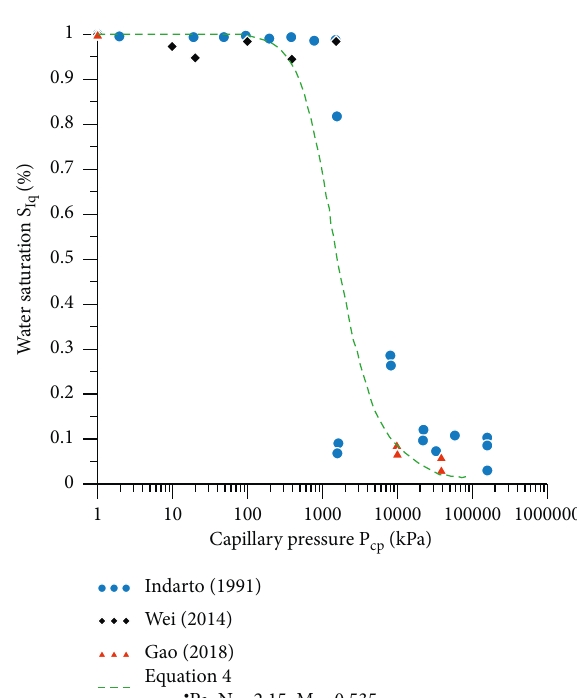
Figure 5: Water retention curve of kaolin